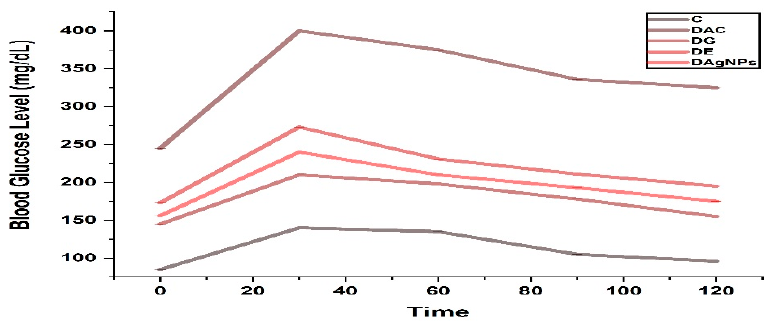
Figure 7. Effect of methanolic extract and synthesized T. couneifolia AgNPs on oral glucose tolerance